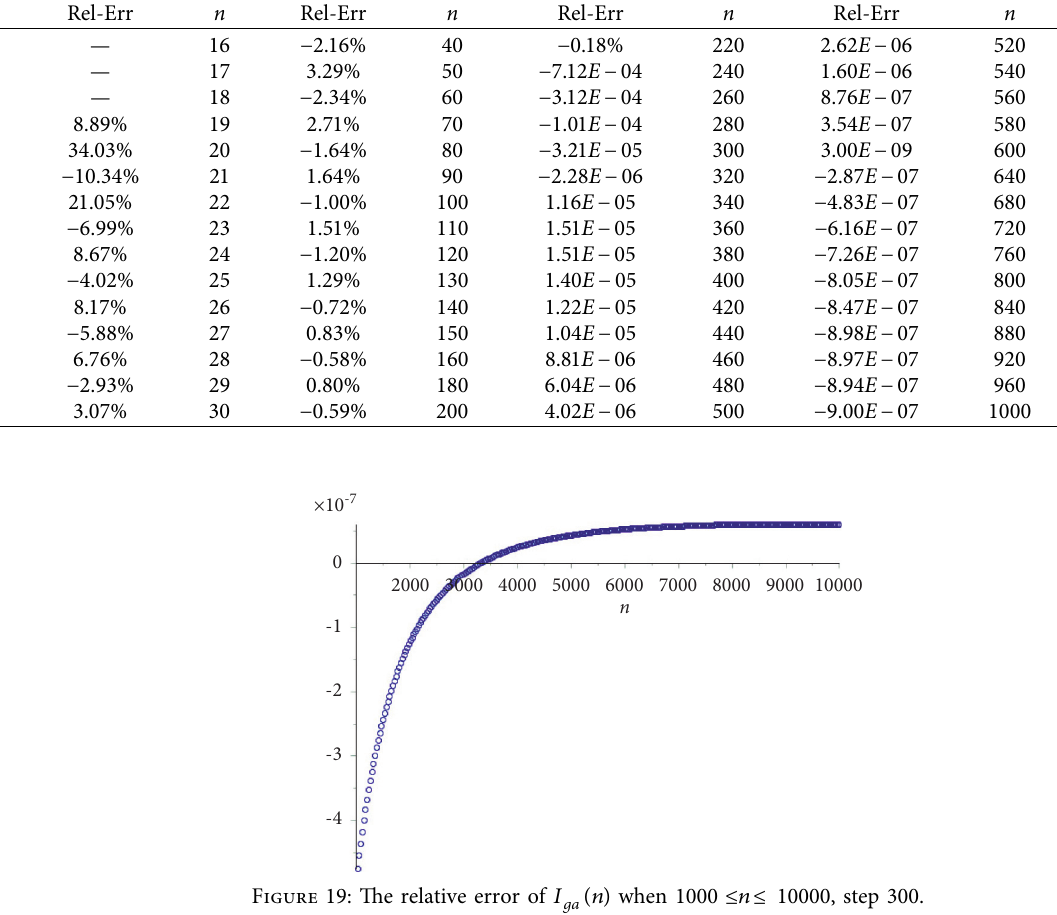
Table 6: The relative error of I